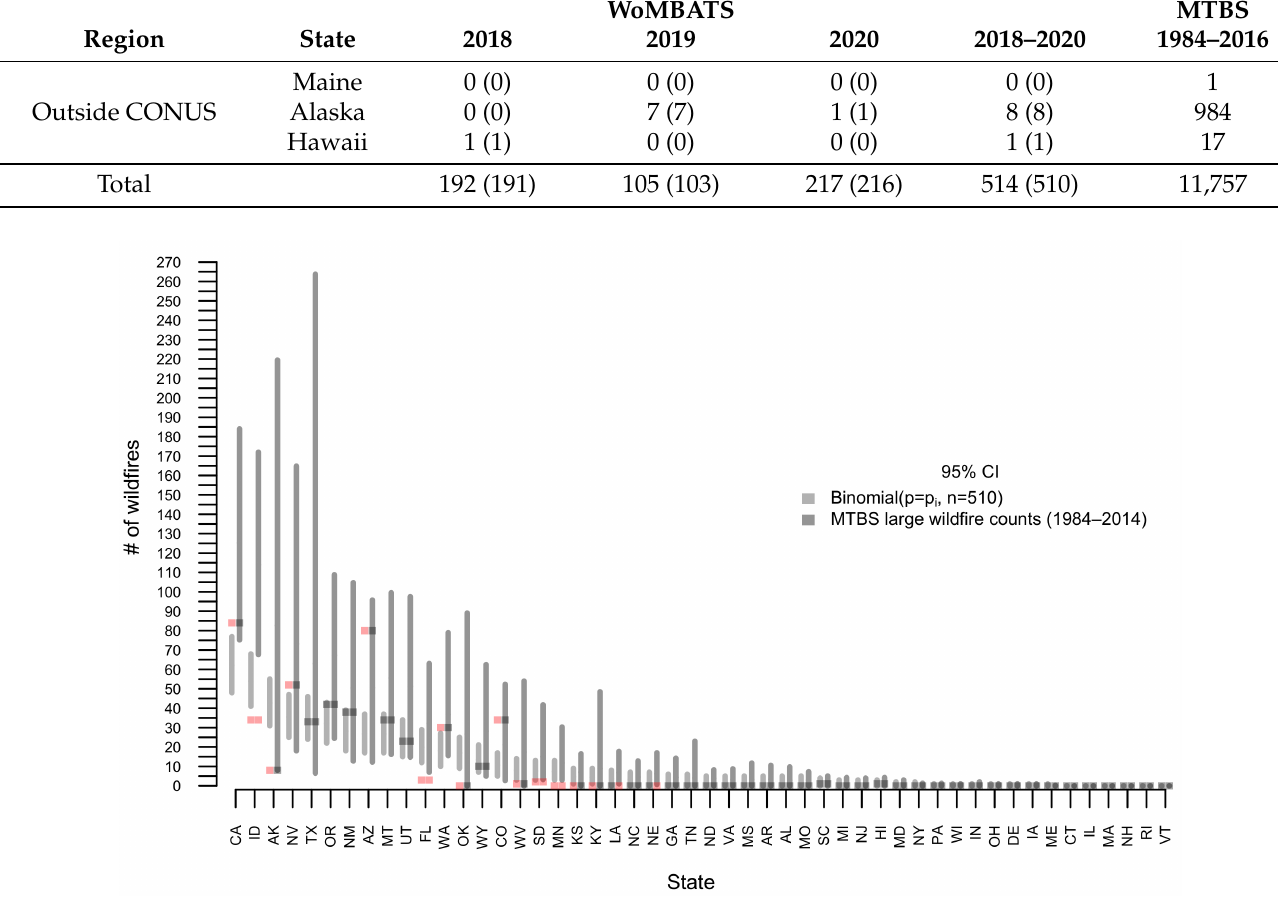
Figure 3. The number of large (>405 ha) fires for each state as reported from WoMBATS data between 2018 and 2020 compared to historical expectations as derived from Monitoring Trends in Burn Severity (MTBS) data. Each square represents the number of large wildfires in the WoMBATS data for each state. Vertical bars are used to represent the central 95th percentile of the expected wildfire counts from the binomial distribution (expected wildfire counts conditional on national counts) and empirical distribution (expected wildfire counts for that state and time-window). Squares that fall outside the central 95th percentile of expected fire counts are colored